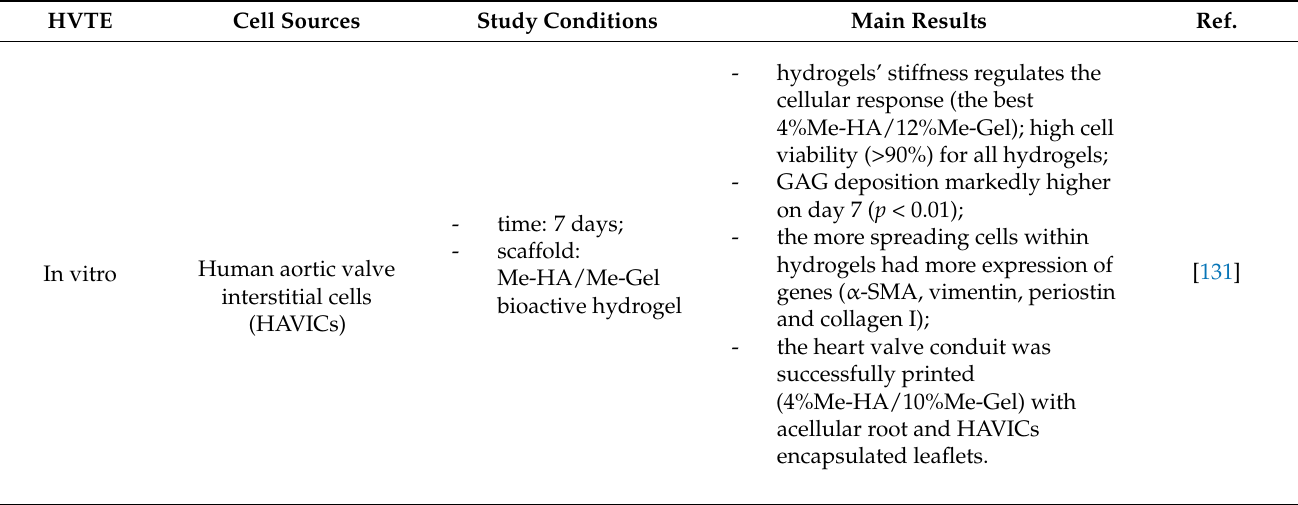
Table 3. Overview of cell sources and scaffold materials used for aortic valve replacement. HVTE Cell Sources Study Conditions Main Results